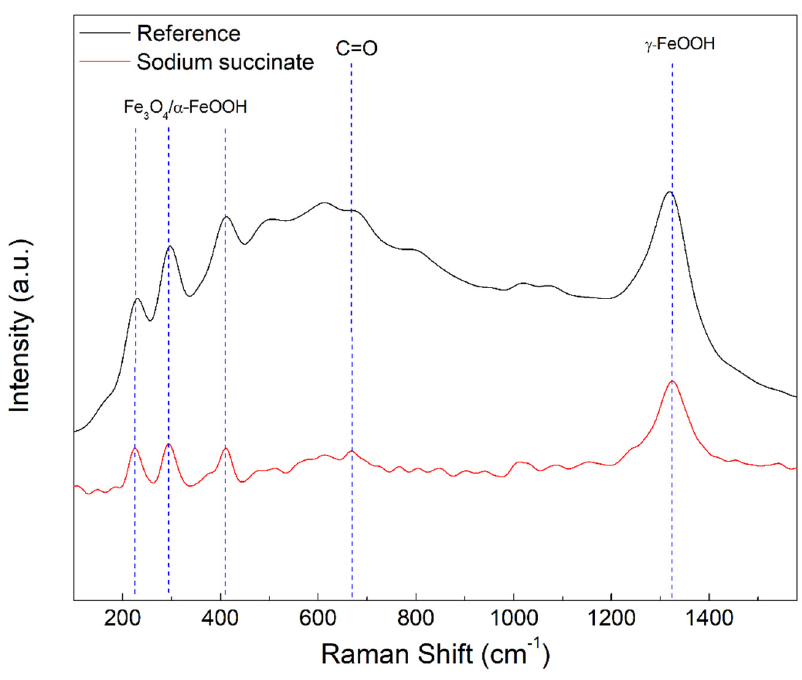
Figure 14. Raman spectroscopy on the inhibited (0.6 M sodium succinate) and uninhibited (reference) rebar surface after exposure to 0.6 M Cl − SCPS at 25 °C.